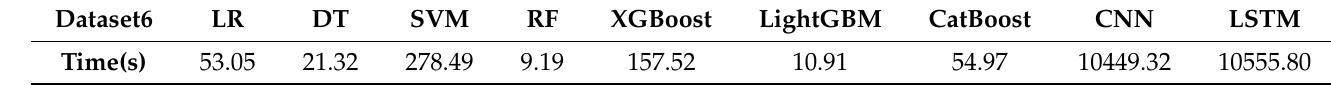
Table 14. Time consumption of different